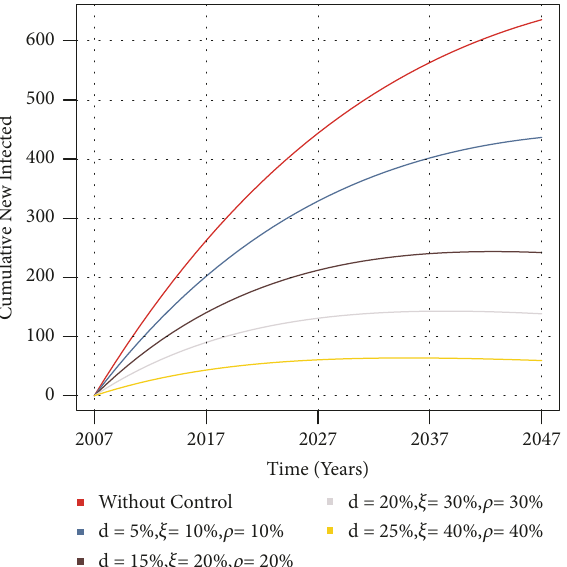
Figure 7: Sensitivity analysis considering detection and treatment of infected individuals 𝑑 , treatment of infected newborns 𝜌 , and surveillance in blood transfusion transmission 𝜉 .